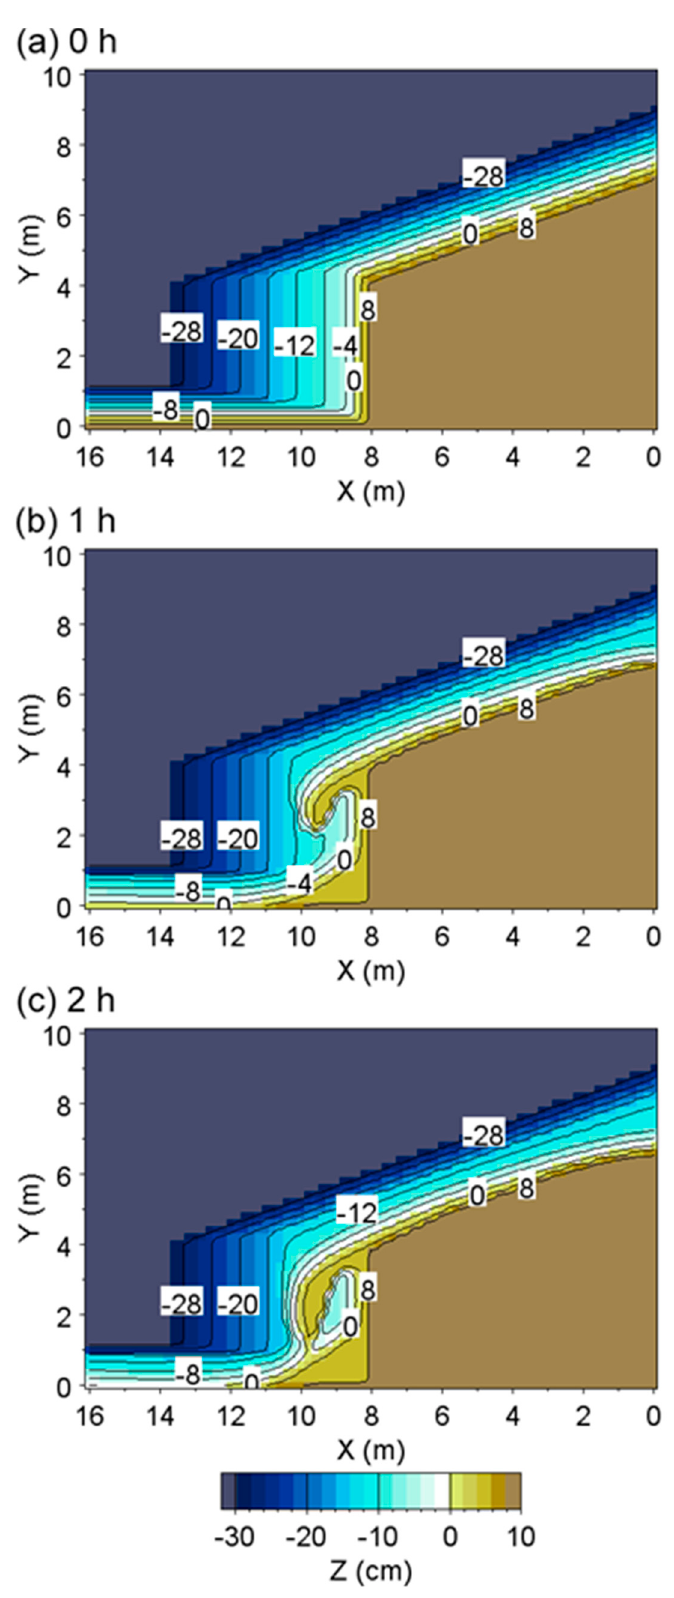
Figure 28. Elongation of sand spit and formation of barrier island [4]. ( a ) Initial topography, ( b ) A sand spit started to elongate from the corner owing to successive deposition of sand supplied by leftward longshore sand transport, ( c ) The tip of the sand spit attached opposite shore, forming a barrier island.